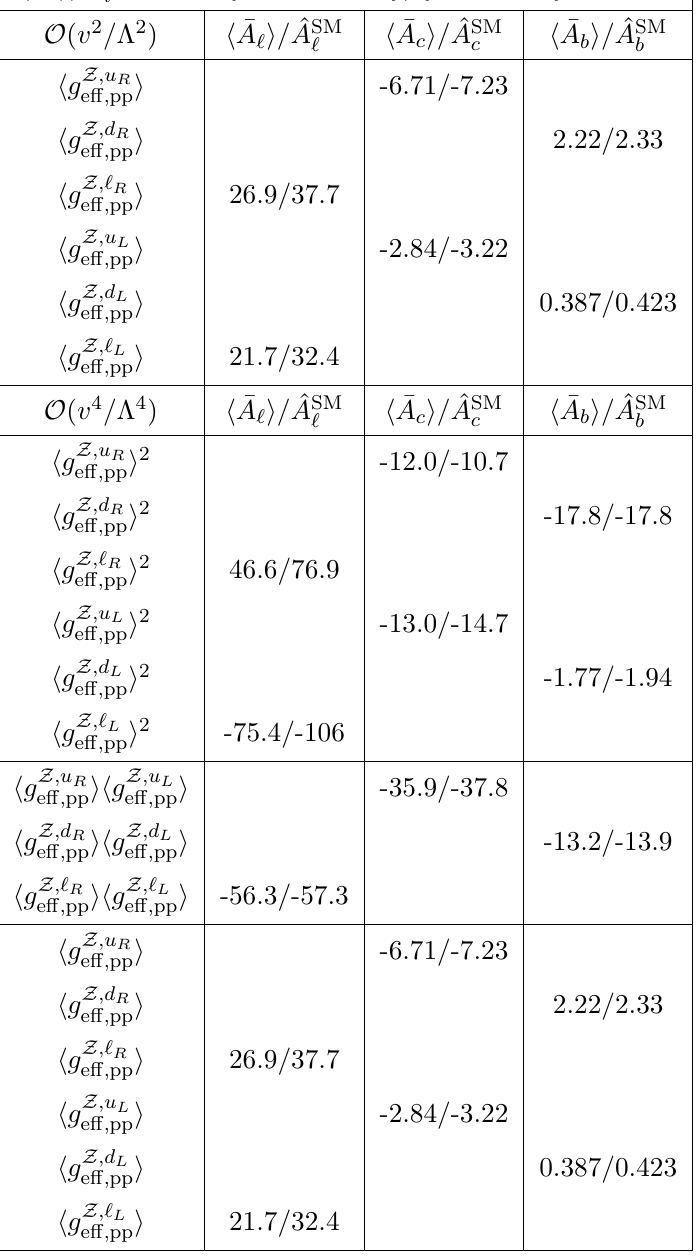
Table 4 . Numerical coefficients defining the dependence on the SMEFT effective couplings in forward backward asymmetries. The expressions are normalized to the tree level SM values in each input parameter scheme: ˆ A SM = 0 . 70 / 0 . 70 , ˆ A SM = 0 . 94 / 0 . 94 , ˆ A SM = 0 . 21 / 0 . 15 . The c b ‘